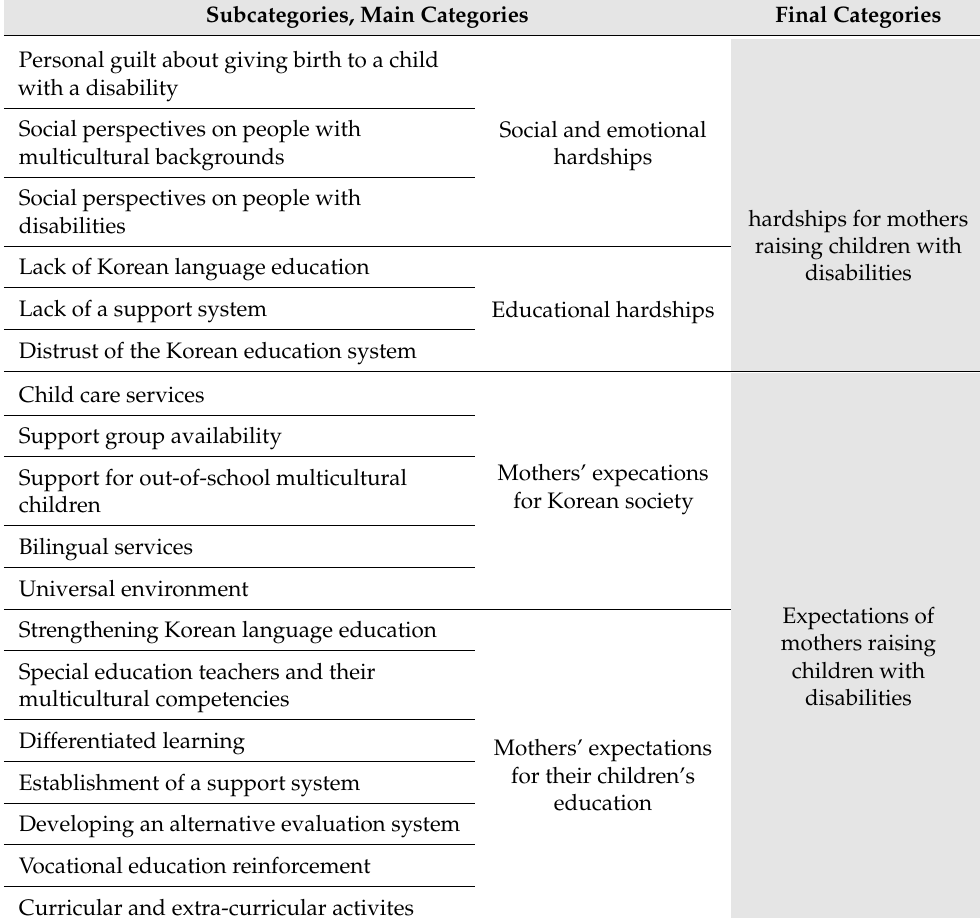
Table 2. Inter-case analysis of female marriage immigrants. Subcategories, Main